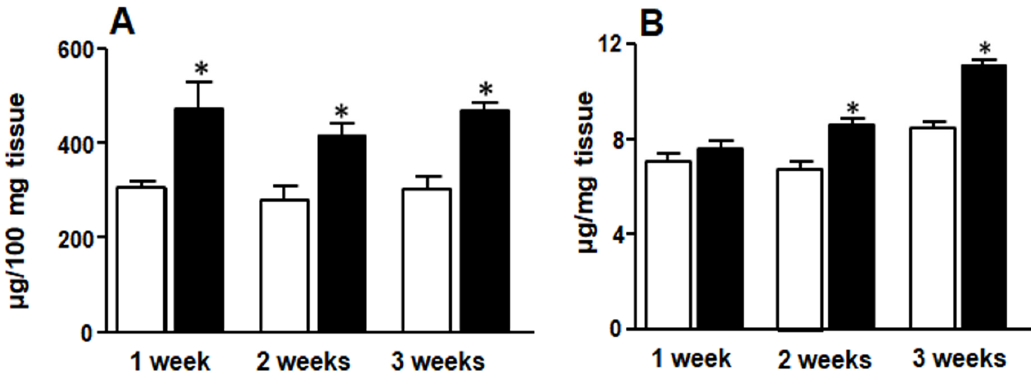
Figure 3. Liver triglyceride ( A ) and glycogen content ( B ). White bars: control group (C rats), black bars: rats fed FRD (F rats). Values are expressed as means ± SEM ( n = 12 rats per group) * p < 0.05 compared to each control at each time point.